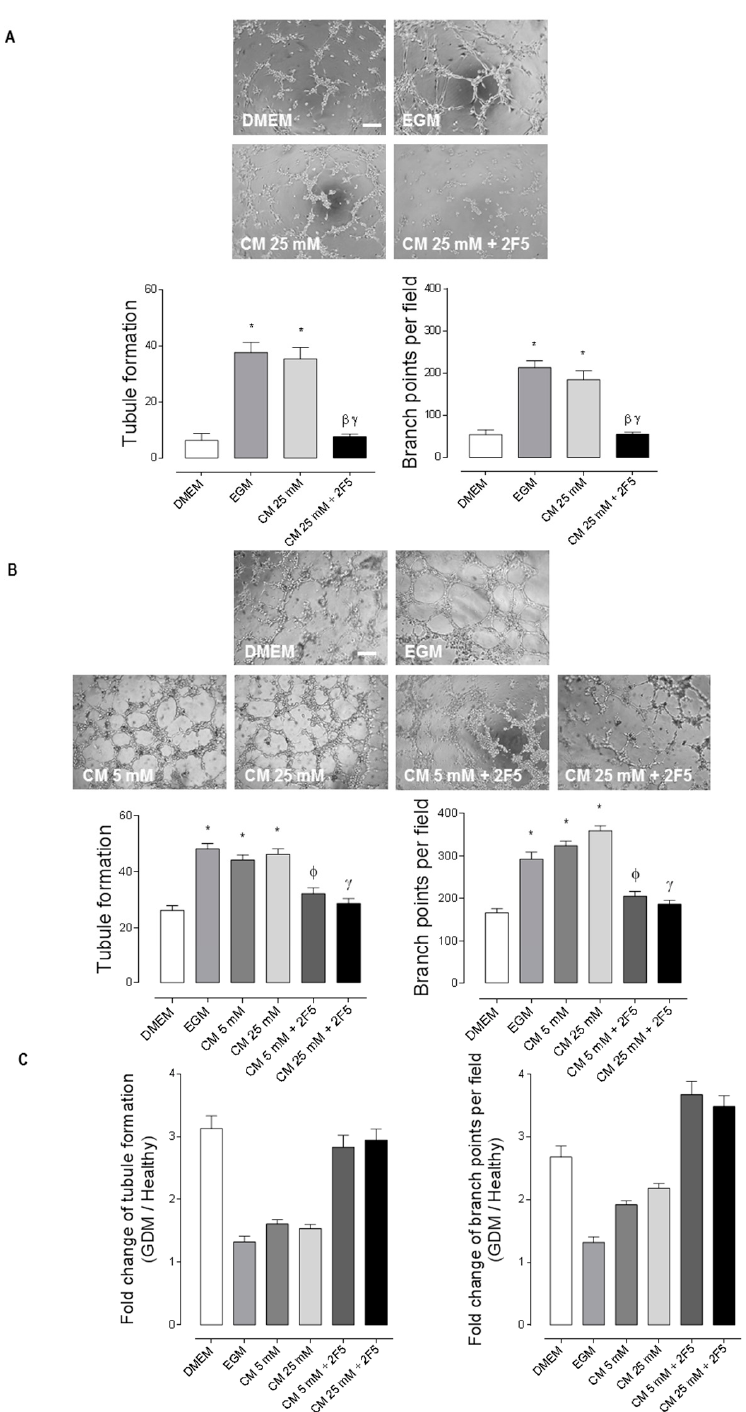
Figure 2. Netrin-1 produced by healthy WJ-MSC promotes angiogenesis in GDM HUVEC independently of D -glucose condition. ( A – C ) Representative images of Matrigel tubule formation and branch points per field of either normal HUVEC ( A ) or GDM HUVEC ( B ) exposed 4 h to DMEM, EGM or CM (48 h) from WJ-MSC grown in D -glucose as indicated and in absence or presence of 2F5 (2 µ g/mL). Scale bar = 15 µ m. A. Quantified data correspond to the mean ± S.E.M. (CM WJ-MSC and healthy HUVEC, n = 3, * p < 0.05 vs. DMEM, β p < 0.05 vs. EGM, γ p < 0.05 vs. CM 25 mM). ( B ) Quantified data correspond to the mean ± S.E.M. (CM WJ-MSC and GDM HUVEC, n = 3, * p < 0.05 vs. DMEM, Φ p < 0.05 vs. CM 5 mM, γ p < 0.05 vs. CM 25 mM). ( C ) Fold change of tubule formation assay in healthy versus GDM HUVEC. Quantified data correspond to the mean ± S.E.M. 2.3. Downregulation of the Anti-Angiogenic UNC5b Receptor could Explain the Increased Angiogenesis Observed in GDM HUVEC